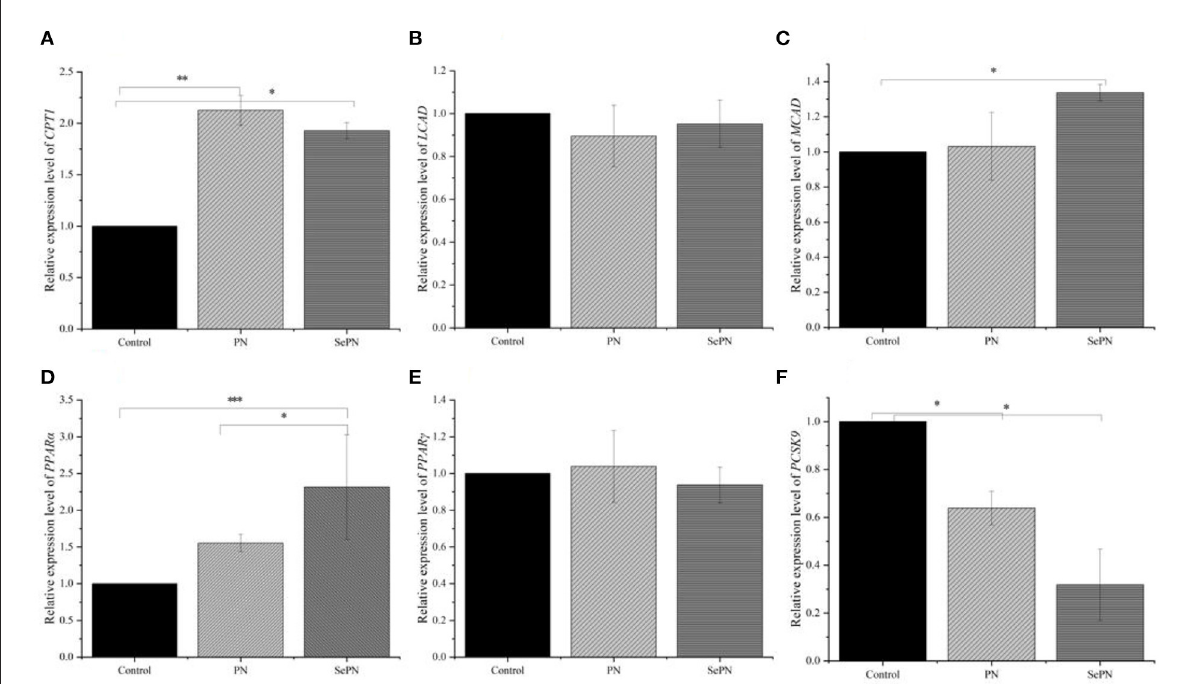
FIGURE5 Detection of the expression of glucolipid metabolism related genes by RT-PCR. (A) . The relative abundance of mRNA of CPT1 . (B,C) The relative abundance of mRNA of LCAD and MCAD . (D,E) mRNA relative abundance of PPAR- α and PPAR- γ . (F) The relative abundance of mRNA of PCSK9 . Data are expressed as the mean ± SD. * P < 0.05, ** P < 0.01, *** P < 0.001 and compared with the control groups ( n =